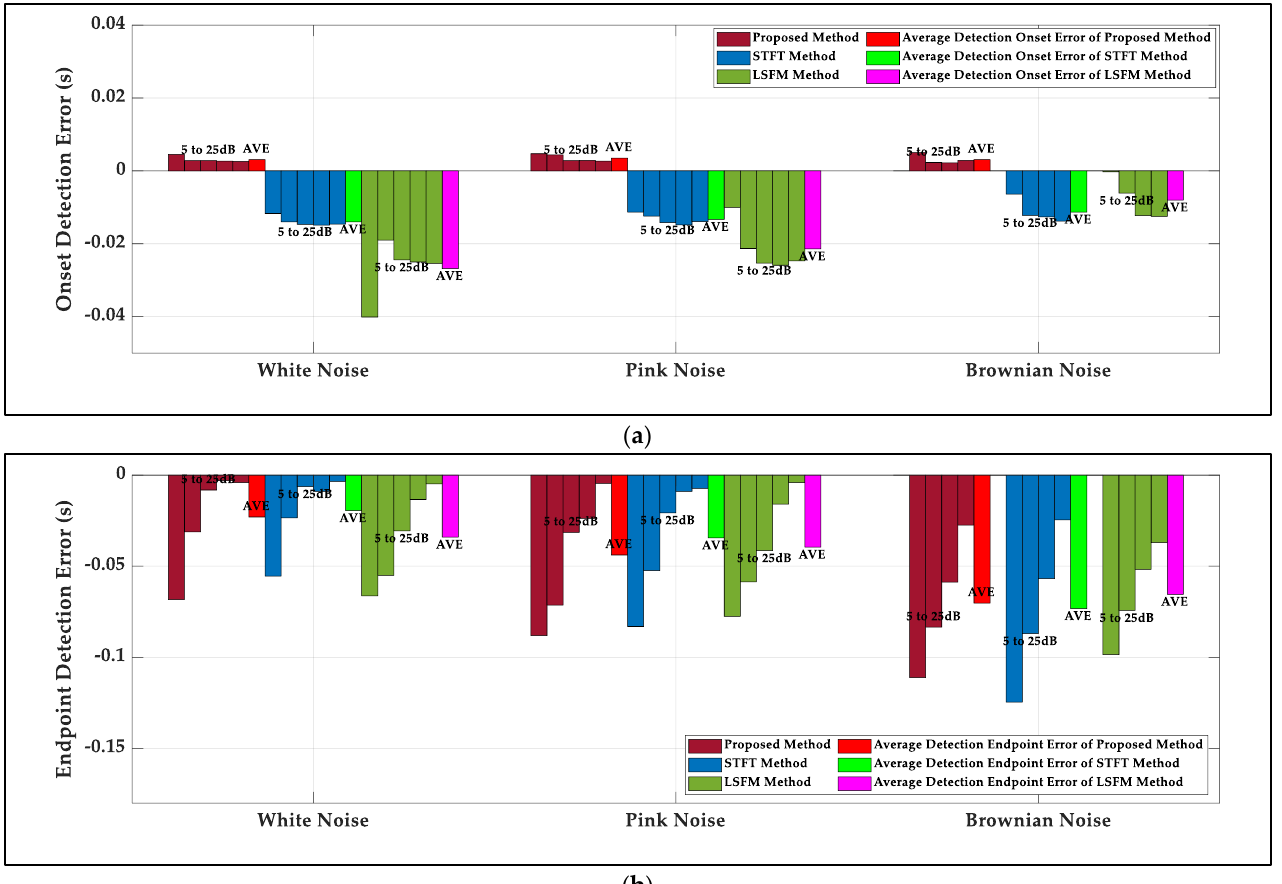
Figure 4. The onset and endpoint detection errors of the LSFM method, the STFT method and the proposed method at 5 to 25 dB SNR for three kinds of noise: ( a ) the onset detection errors of three methods at 5 to 25 dB SNR for three kinds of noise; ( b ) the endpoint detection errors of three methods at 5 to 25 dB SNR for three kinds of noise.